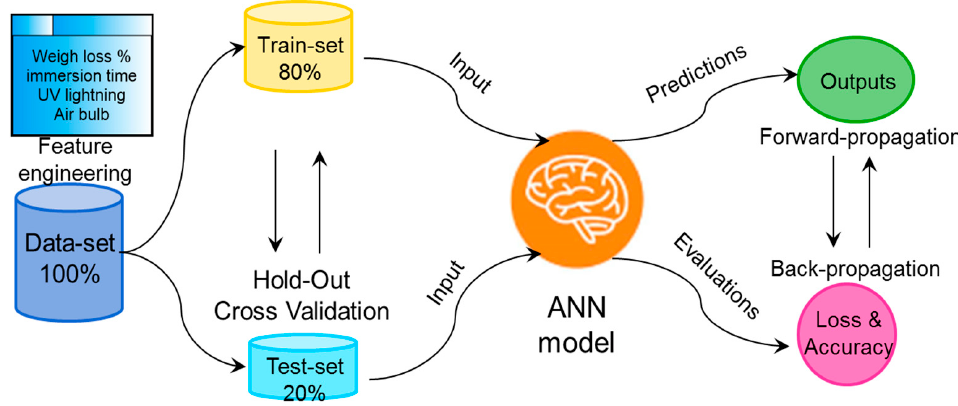
Figure 3. Flow chart of the proposed ANN model for predicting the degradation process of PLA/PHB fabrics.